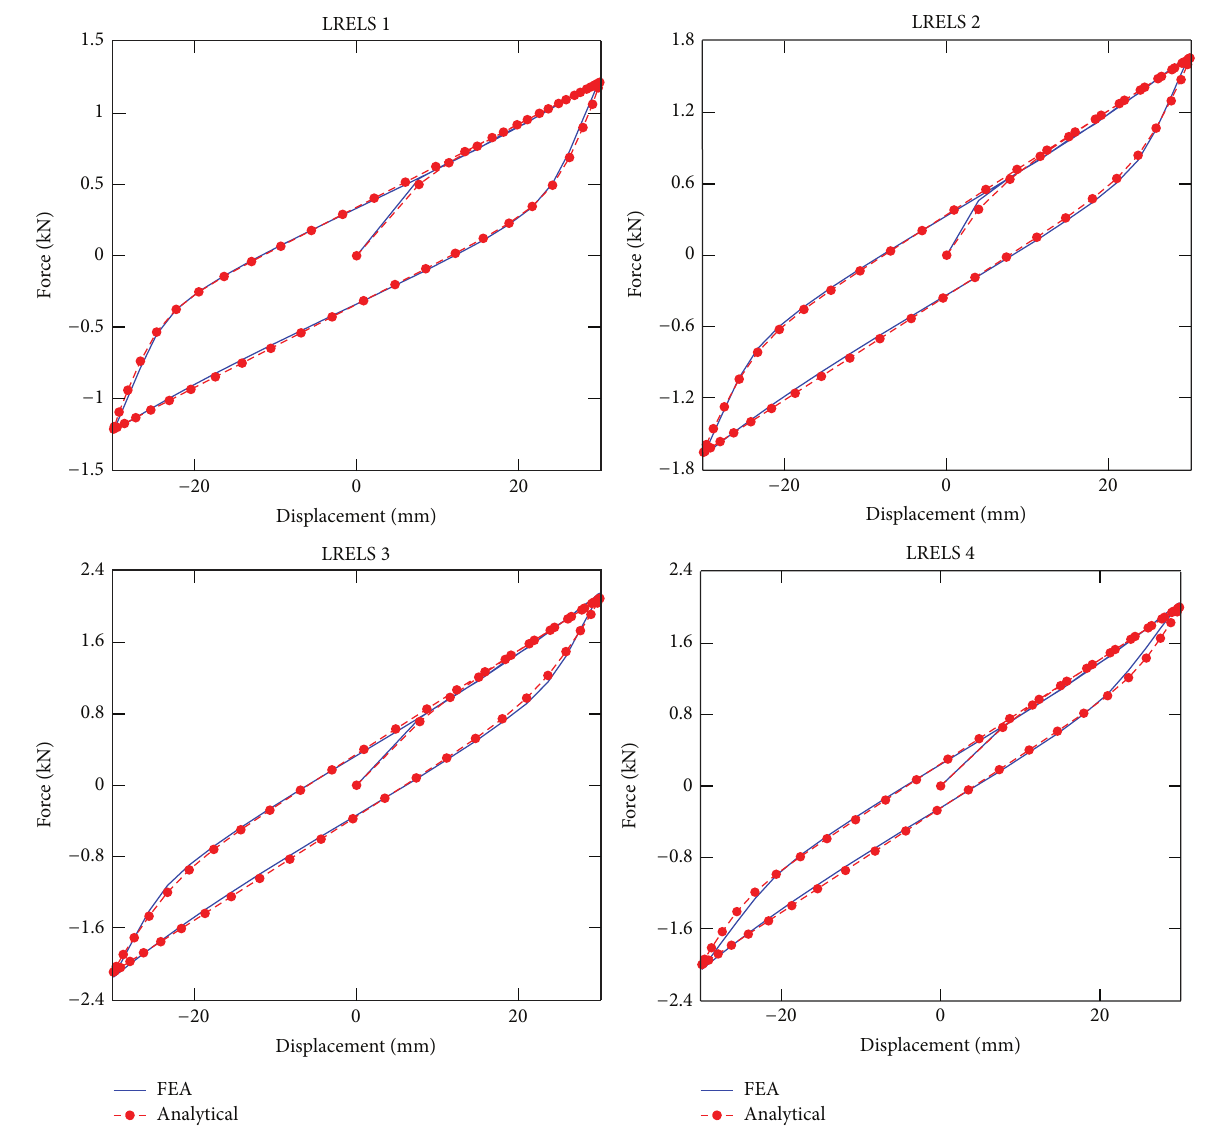
Figure 6: In-plane force-displacement curves. Table 3: Parameters of model isolators in the out-of-plane horizontal direction.